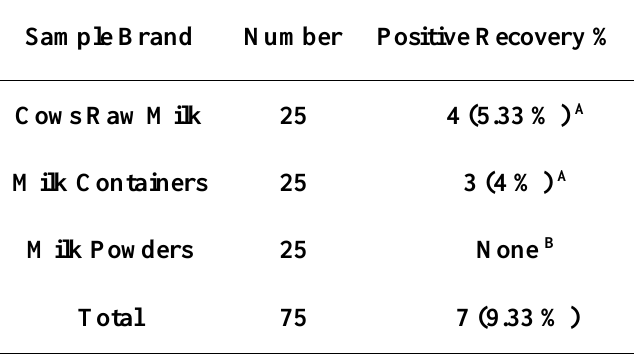
Figure 1. Growth and hemolysis pattern of E. faecalis on modified sodium azide blood